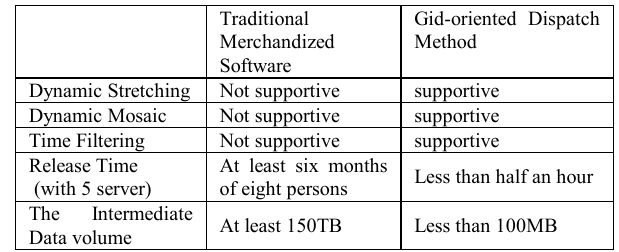
Table 1. The Comparison between Traditional Merchandized Software and the Gid-oriented Dispatch Method